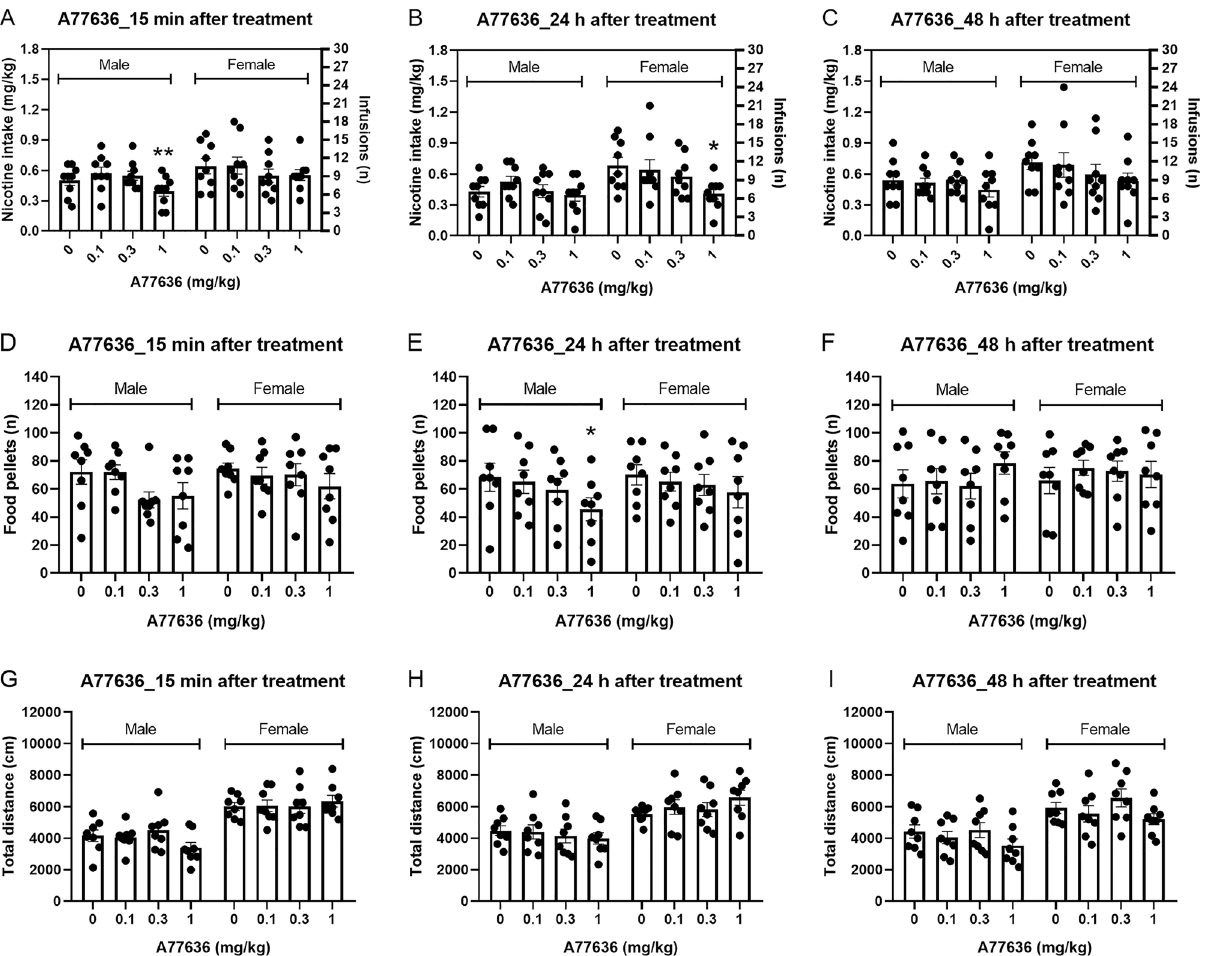
Figure 2. Effects of the D1-like receptor agonist A77636 on nicotine and food intake and locomotor activity in male and female rats. The effects of A77636 on nicotine ( A 15 min; B 24 h; C 48 h) and food intake ( D 15 min; E 24 h; F 48 h) and locomotor activity ( G 15 min; H 24 h; I 48 h) were investigated. Treatment with A77636 decreased nicotine intake 15 min, 24 h, and 48 h later. A77636 decreased food intake at the 15 min and 24 h time point and locomotor activity at the 48 h time point. Nicotine self-administration (males n = 9, females, n = 9), operant responding for food and small open field test (males n = 8, females, n = 8). Asterisks indicate a significant difference from rats of the same sex that received vehicle. *P < 0.05, **P < 0.01. Data are expressed as means ± Treatment with A77636 or sex did not affect responding on the inactive lever (Fig. S5D, Treatment F3,48 = 1.472, NS; Sex F1,16 = 0.361, NS; Treatment × Sex F3,48 = 2.711, NS). 24‑h post A77636 treatment. Nicotine intake was decreased 24 h after treatment with A77636 and nicotine intake was not affected by the sex of the rats (Fig. 2B, Treatment F3,48 = 5.857, P < 0.05; Sex F1,16 = 3.137, NS; Treatment × Sex F3,48 = 2.204, NS). The posthoc test showed that 1 mg/kg of A77636 decreased nicotine intake in the females. Responding on the active lever was decreased after treatment with A77636 and there was no sex effect (Fig. S5B, Treatment F3,48 = 5.341, P < 0.01; Sex F1,16 = 3.302, NS; Treatment × Sex F3,48 = 2.516, NS). Treatment with A77636 or sex did not affect responding on the inactive lever (Fig. S5E, Treatment F3,48 = 1.557, NS; Sex F1,16 = 0.758, NS; Treatment × Sex F3,48 = 1.018, NS). 48‑h post A77636 treatment. Nicotine intake was decreased 48 h after treatment with A77636 and there was no effect of sex on nicotine intake (Fig. 2C, Treatment F3,48 = 3.527, P < 0.05; Sex F1,16 = 1.639, NS; Treatment × Sex F3,48 = 0.942, NS). Responding on the active lever was also decreased after treatment with A77636 and there was no sex effect (Fig. S5C, Treatment F3,48 = 2.883, P < 0.05; Sex F1,16 = 1.855, NS; Treatment × Sex F3,48 = 0.476, NS). Treatment with A77636 or sex did not affect responding on the inactive lever (Fig. S5F, Treat- ment F3,48 = 0.125, NS; Sex F1,16 = 0.006, NS; Treatment × Sex F3,48 = 2.287, NS).